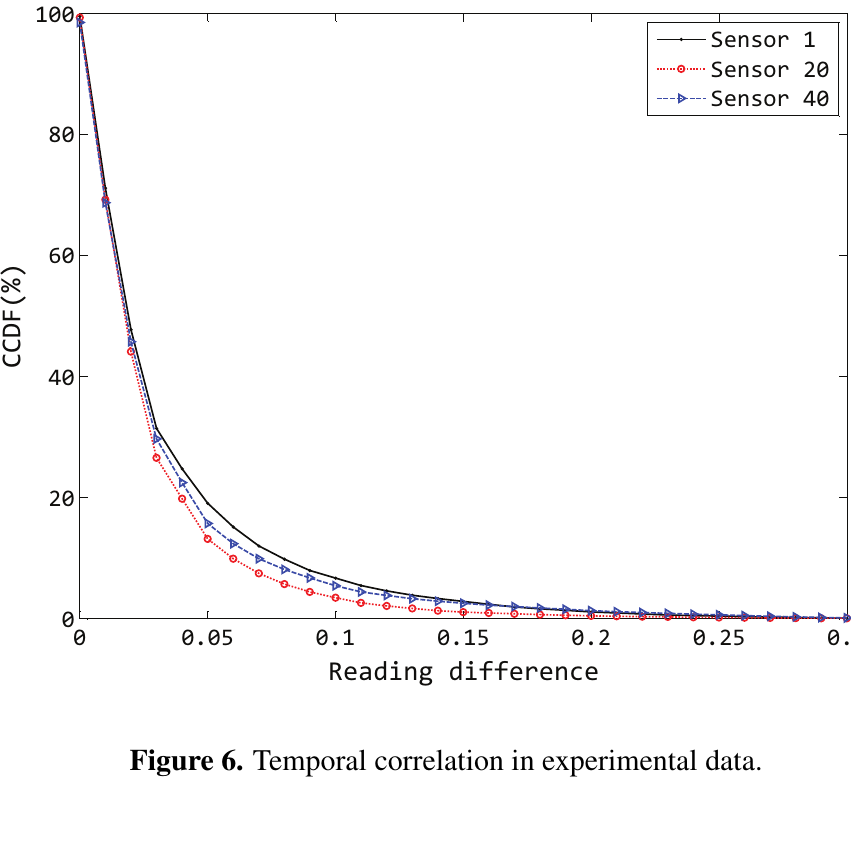
Figure 6. Temporal correlation in experimental data.